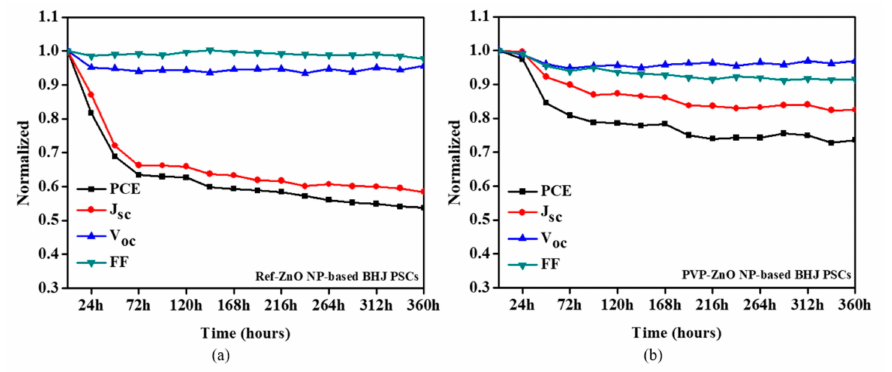
Figure 7. Normalized air-stability characteristics of ( a ) Ref-ZnO NP-based BHJ PSCs and ( b ) PVP-ZnO NP-based BHJ